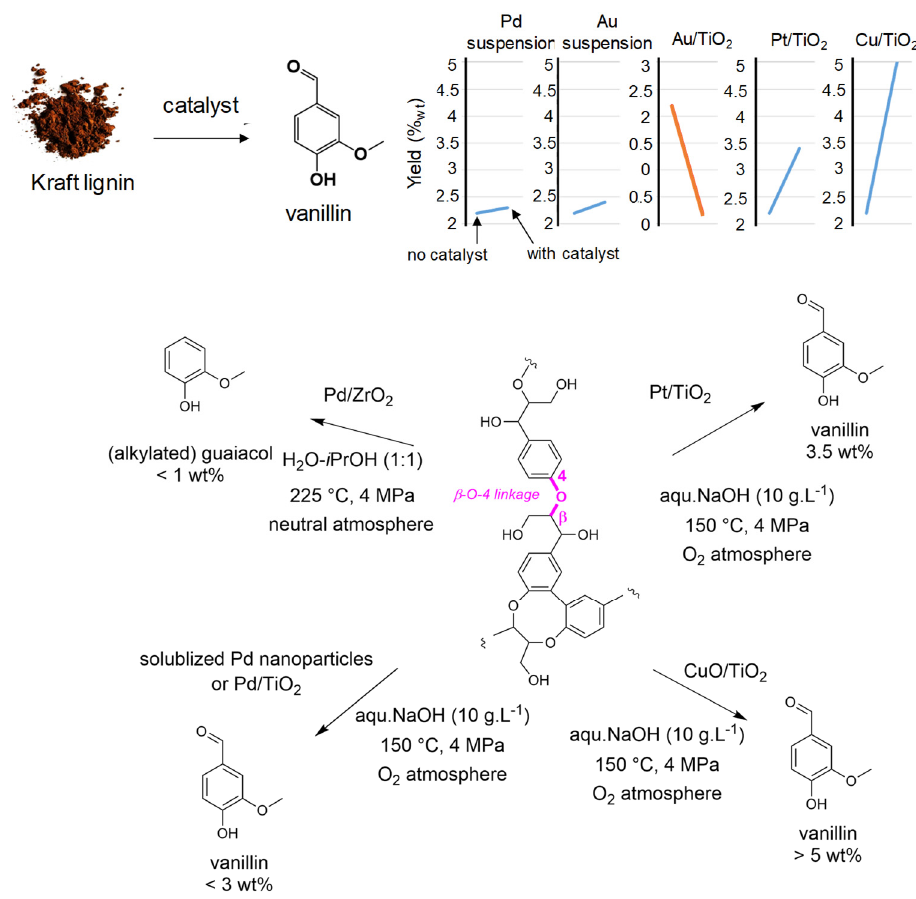
Figure 6. Catalyst development in C’Durable team for oxidative lignin depolymerization to aromatics, mainly vanillin.